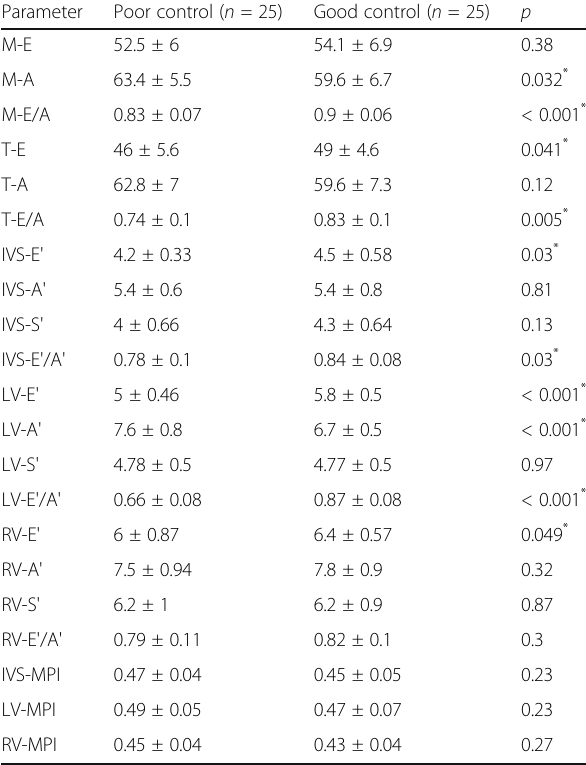
Table 2 Comparison between cases with poor vs. good maternal glycemic control as regards PW-Doppler, TDI, and TDI- based MPI